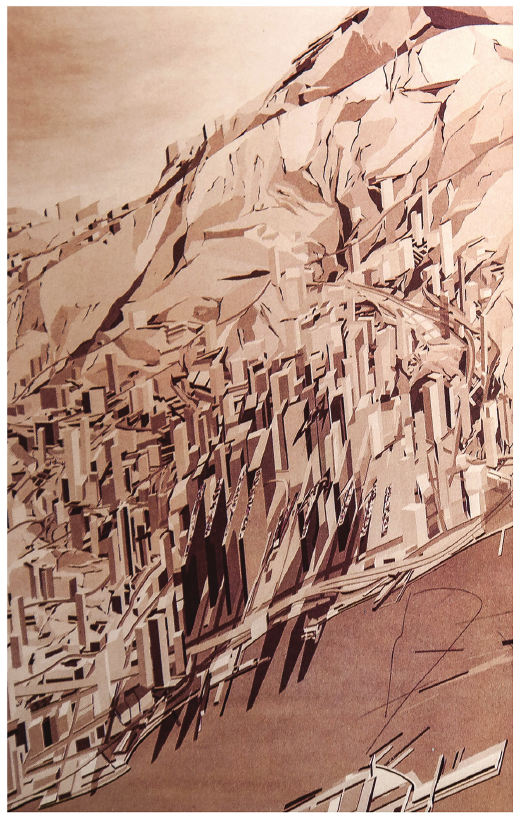
fig. 2. The Peak , Hong Kong, 1982, Zaha M. Hadid presentation design, the 1 st